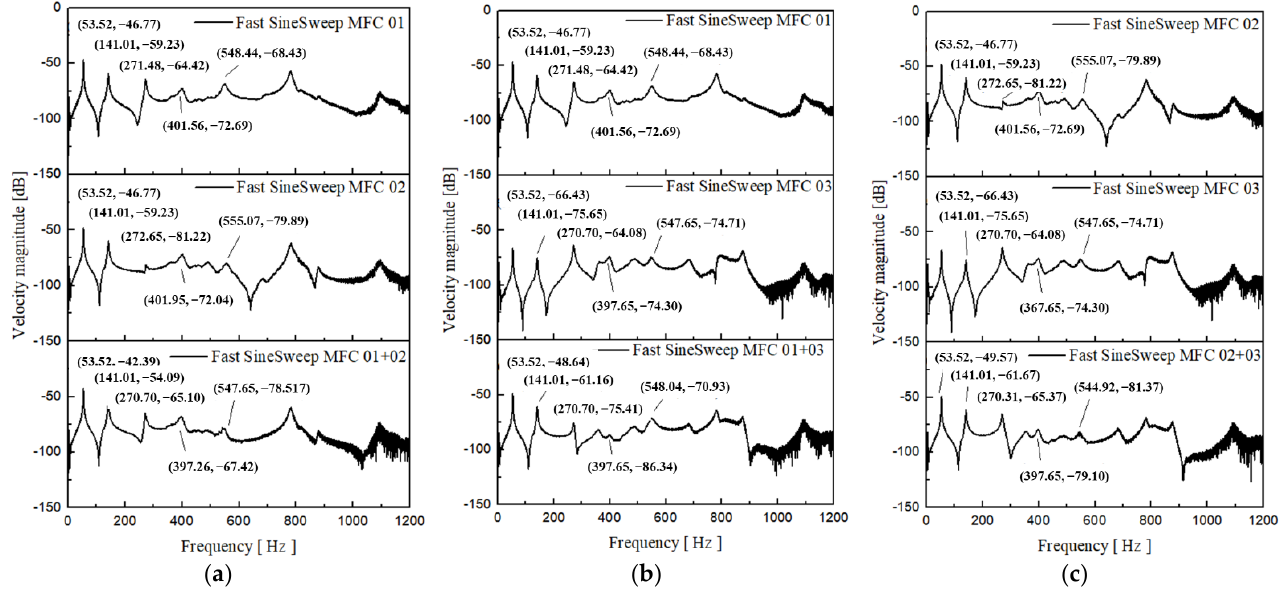
Figure 9. Frequency domain response of Node 127 under single and combined MFC excitation: ( a ) MFC 01 + 02; ( b ) MFC 01 + 03; ( c ) MFC 02 + 03.